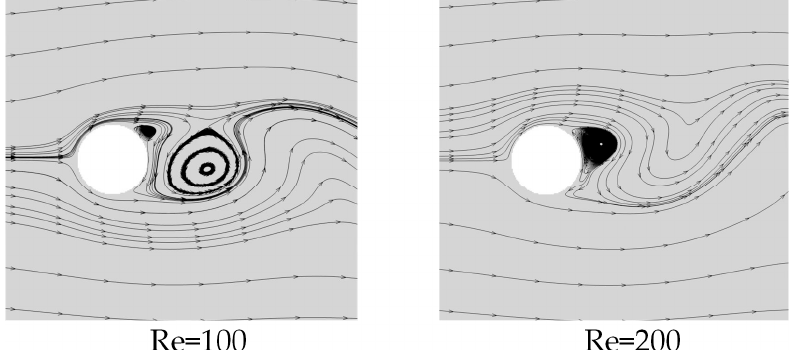
Figure 16. Streamline of the flow around circular cylinder at different Reynolds numbers.